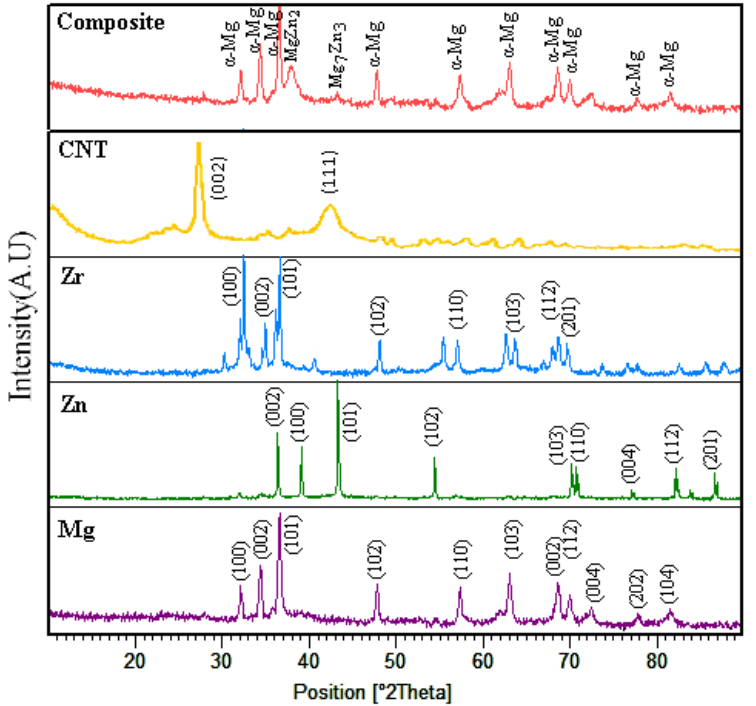
Figure 6. XRD patterns of pure Mg, Zn, Zr and MZ/CNTs composite.